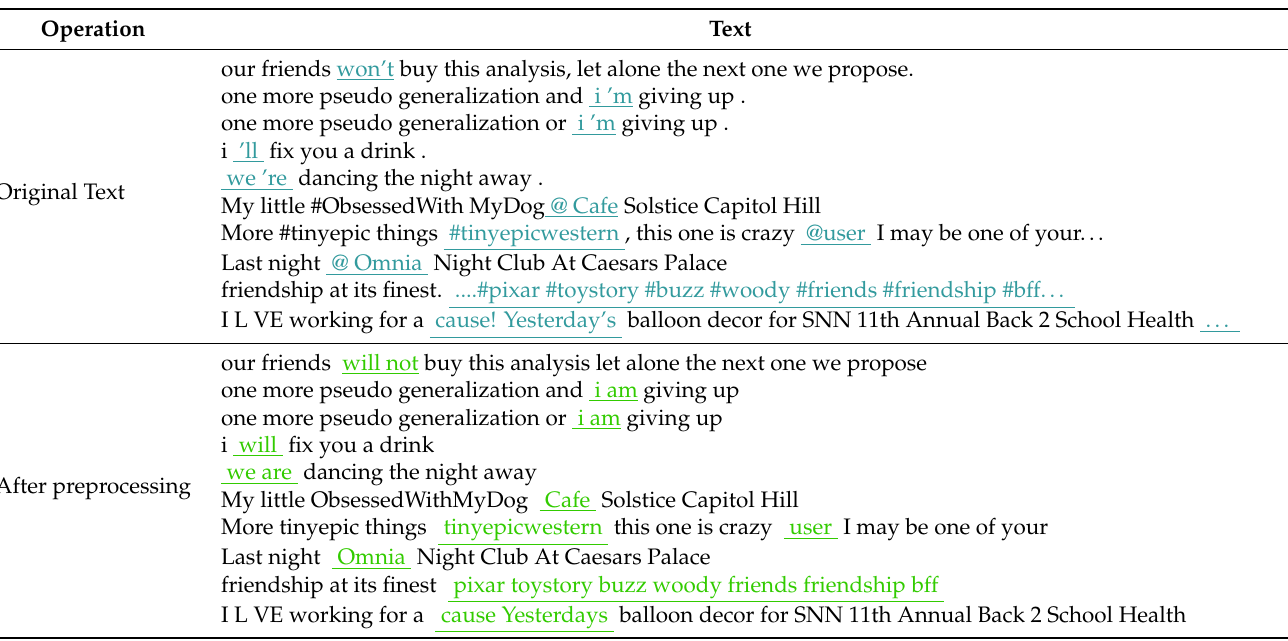
Table 1. Example of data preprocessing for the training set in downstream tasks.